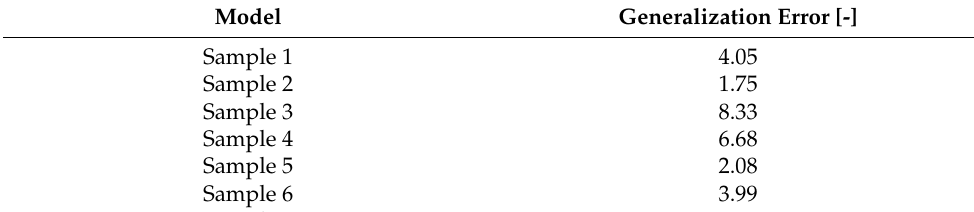
Table 7. Error in applying the trained tactile sensation model to unknown data.